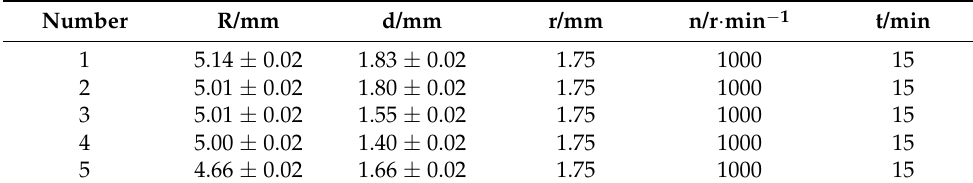
Table 3. Calculation parameters of wear rate under different CaF2 contents.